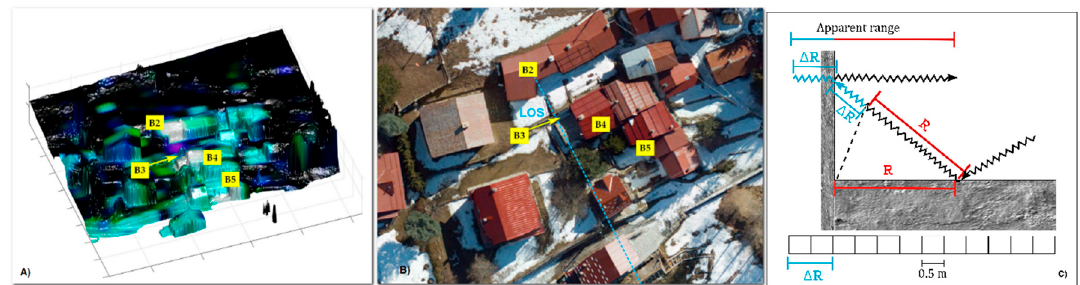
Figure 19 . ( A ) False colour map projected on the DSM; ( B ) picture of two to four houses with a number label and LOS direction. ( C ) Scheme of the two scattering modes. The apparent longer range depends on the additional path covered by the radar signal after the first bounce. Table 5. List of the targets identified in Figure 19. Different grey intensities in the table rows enhance the different behaviour as commented in the text.